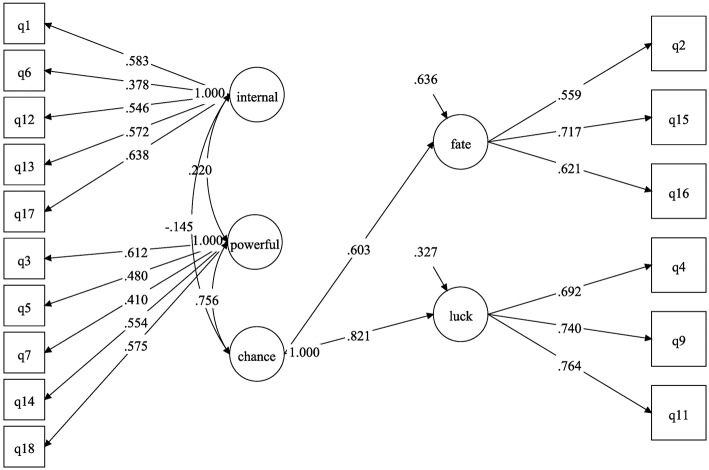
Confirmatory four-factor model of the Perceived Control in Unemployment Scale (Internal, Powerful Others, and Chance dimensions, plus the Luck and Fate subdimensions).